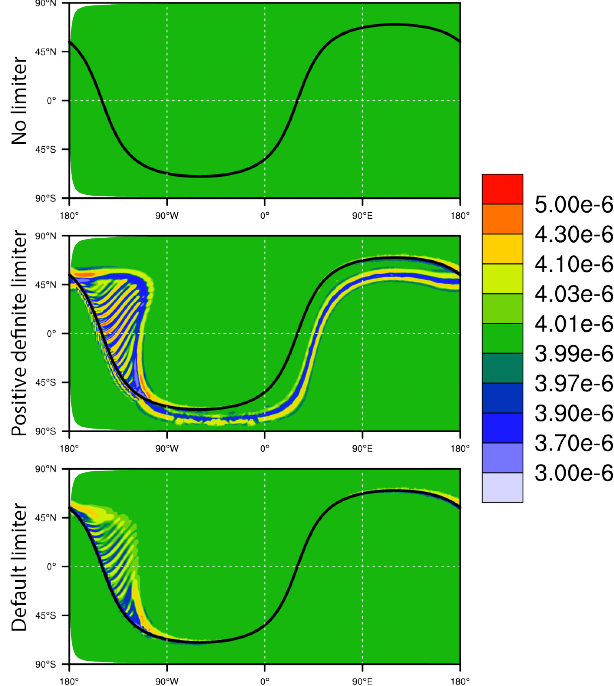
Figure 4. Contour plot of Cl y at day 1 using CAM-SE in ftype = 1 configuration where (upper) no limiter, (middle) positive definite limiter, and the default CAM-SE limiter are applied, respectively. The solid black line depicts the location of the terminator line. Note that the contour levels are not linear.